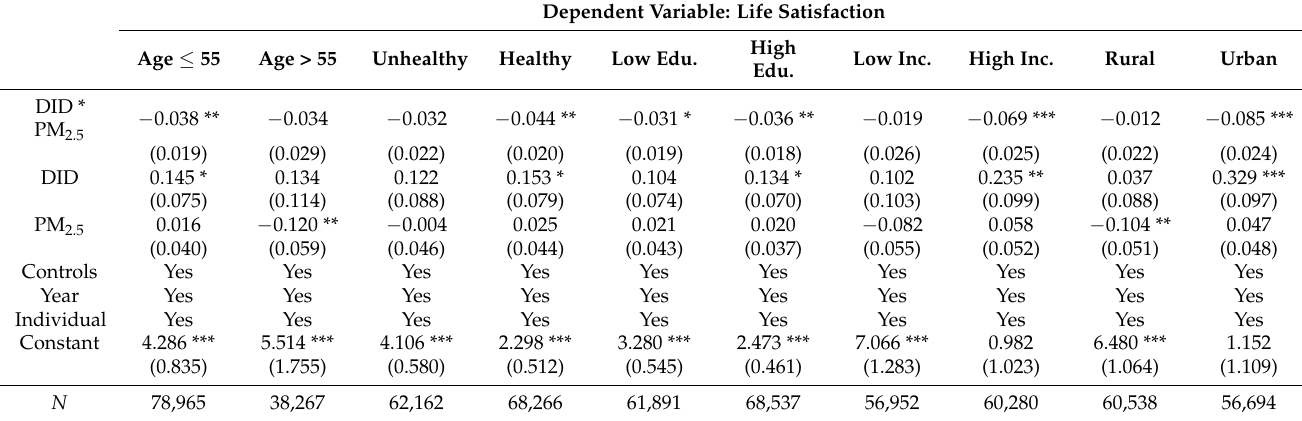
Table 5. Heterogeneity results. Dependent Variable: Life